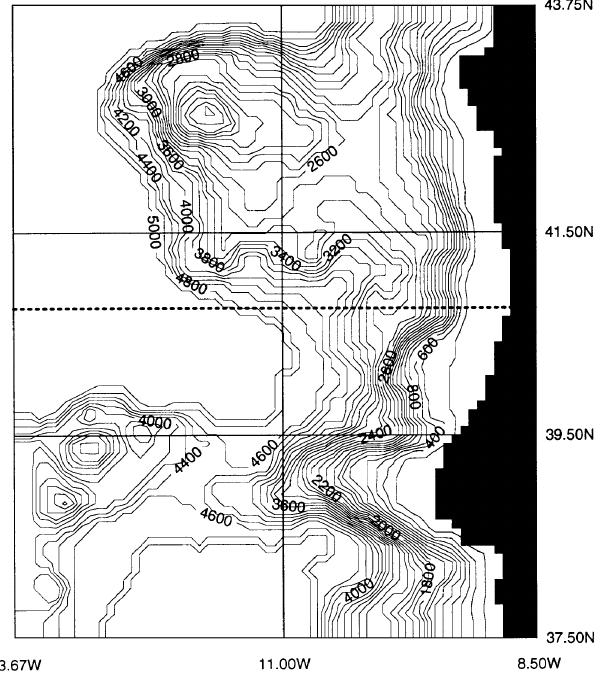
Fig. 2. Model domain and topography. Depths in metres. Dotted line indicates 40.75 ° N zonal